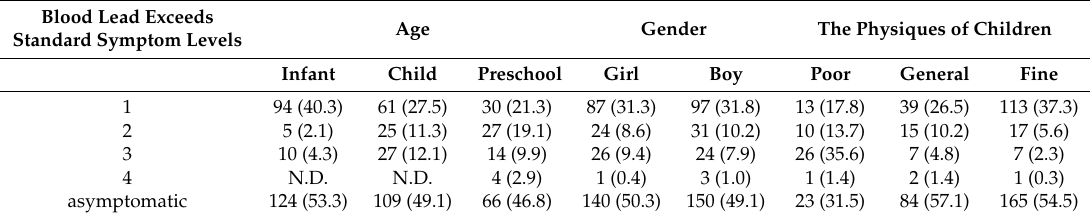
Table 4. The relationship between the basic characteristics of children and CBL.